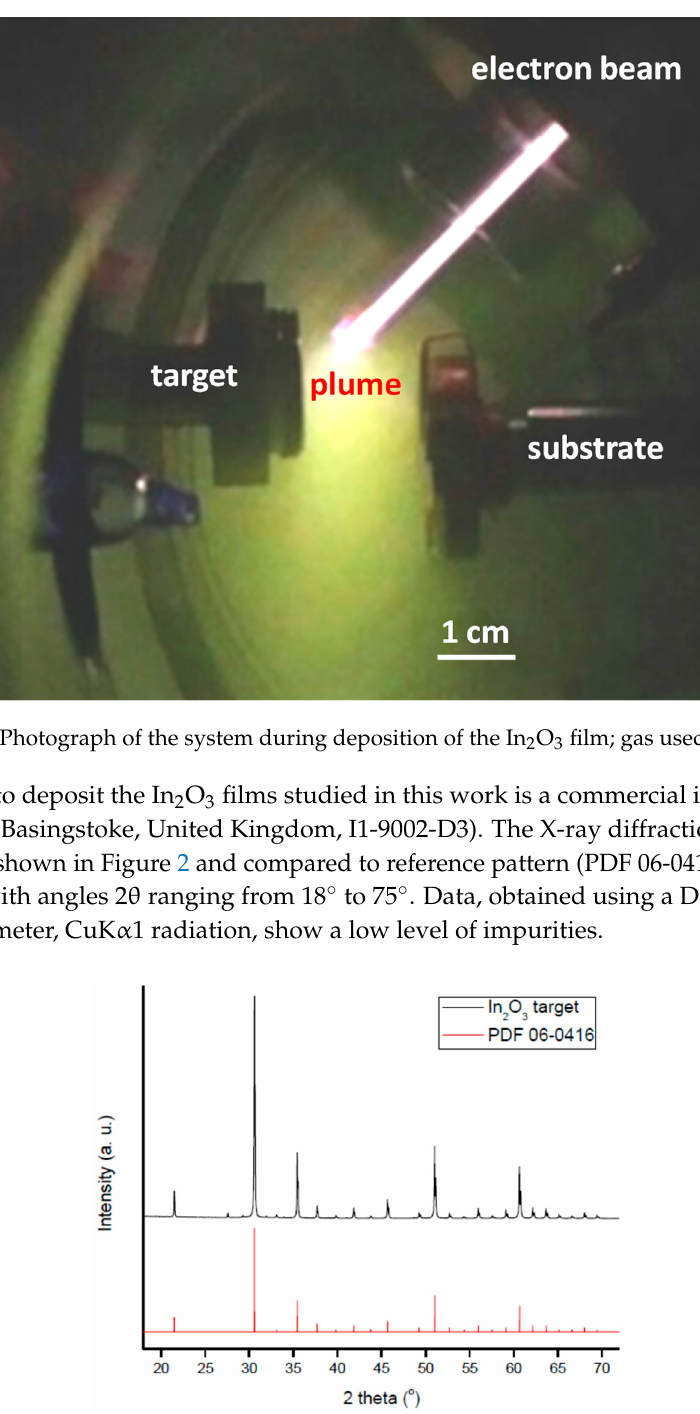
Figure 2. XRD analysis of the target as compared with the reference pattern PDF 06-0416.